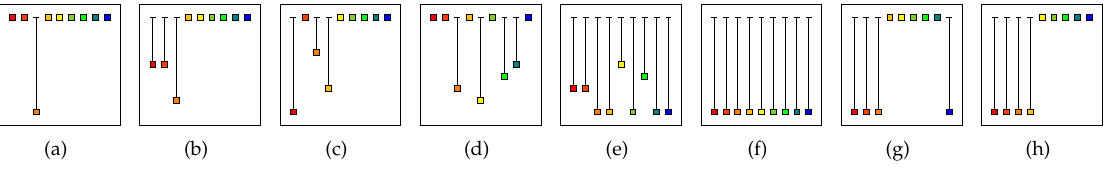
Figure 8. Various Hammond organ registrations and their names. ( a ) 008000000 fundamental; ( b